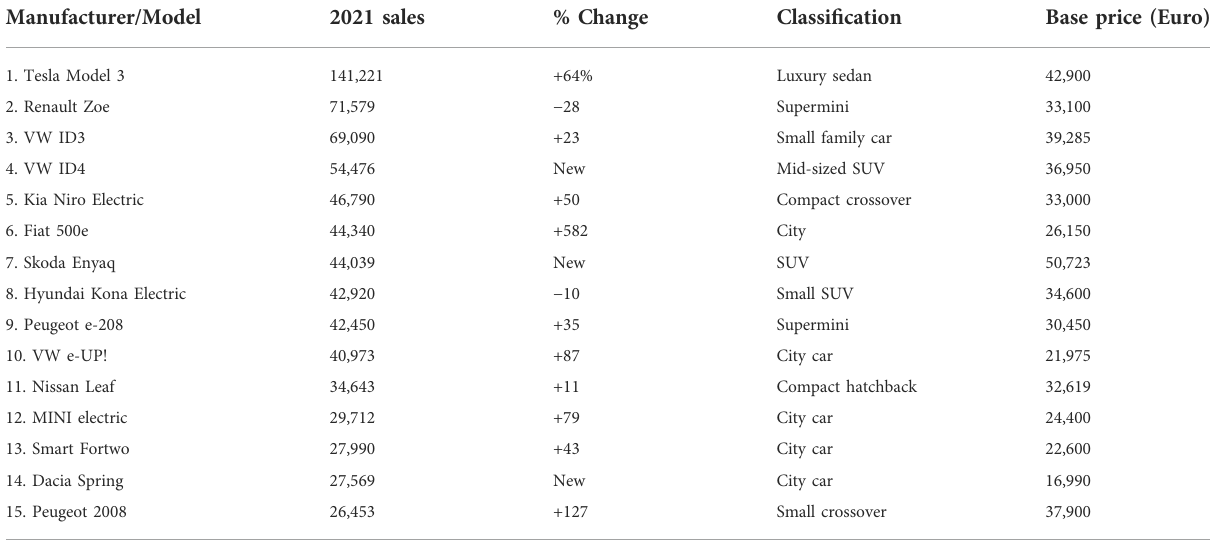
TABLE 7 Top 15 PEV models in Europe-28 By 2021 sales volume, plus % change in sales volume over 2020 and selected vehicle characteristics (Car Sales Statistics, 2022b; WattEV2Buy, 2017). Manufacturer/Model